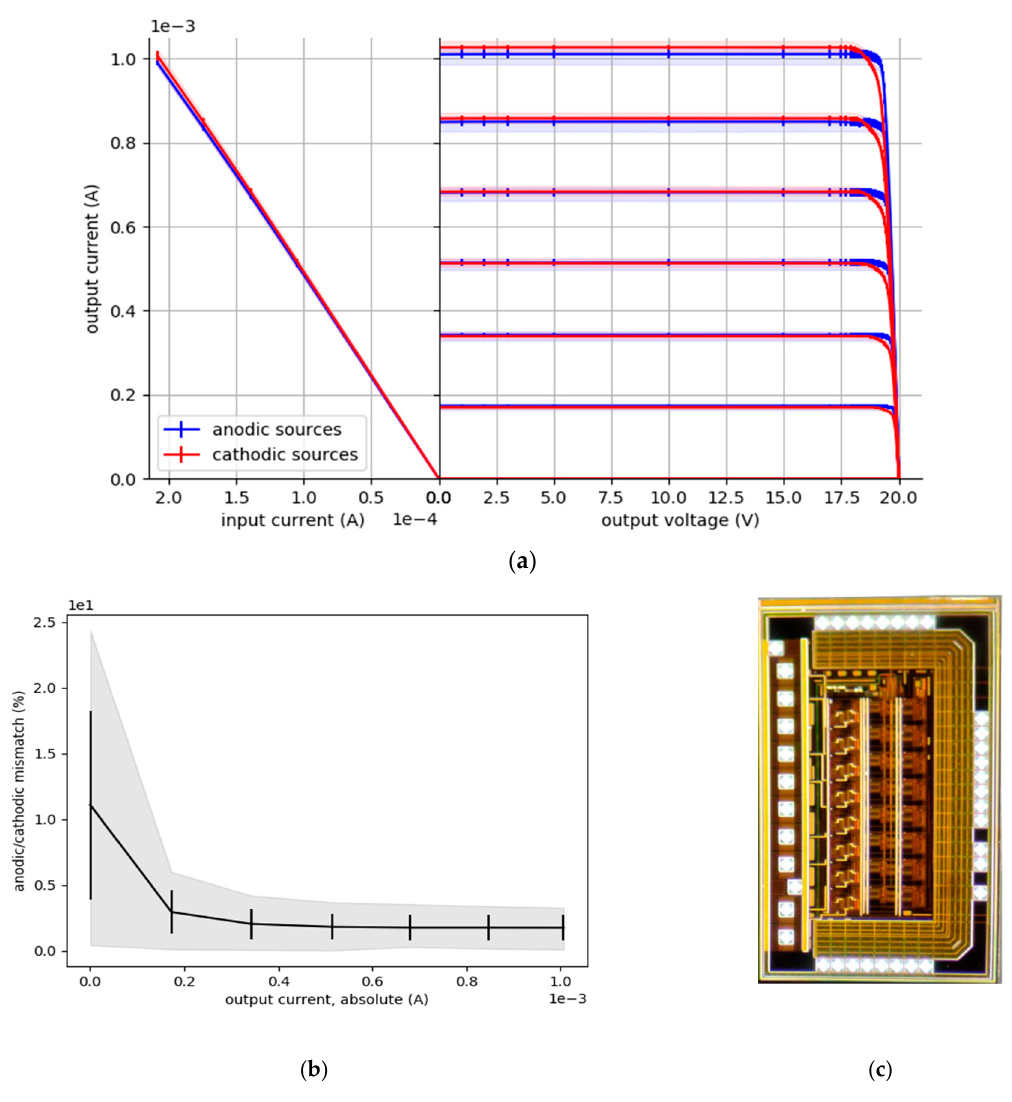
Figure 9. ( a ) Elementary Stimulation Channels characterization measurements; both transfer (output current as a function of input current) and output (output current as a function of output voltage) characteristics for anodic and cathodic sources are plotted. Curves represent the average characteristic, bars the standard deviations, and colored areas the maximum range. ( b ) Fine characterization of anodic versus cathodic mismatch over the stimulation current range. ( c ) Microphotography of the chip SONIC for High Voltage current stimulation of electrodes; HV pads are located on the left of the chip, LV pads on top, right and bottom sides. The die chip is 4.78 mm 2 large and core-limited.